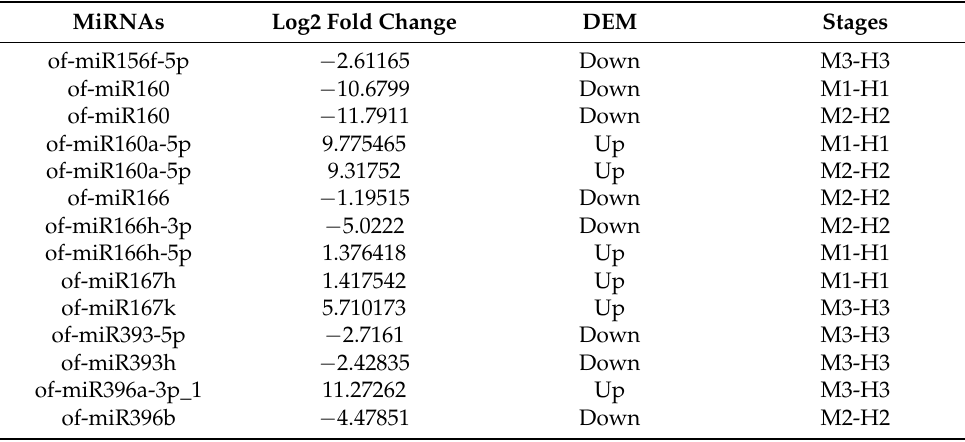
Table 2. The main differentially expressed miRNAs in three stages. MiRNAs Log2 Fold Change DEM Stages of-miR156f-5p − 2.61165 Down